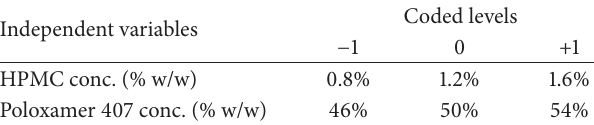
Table 2: Coded level for variable